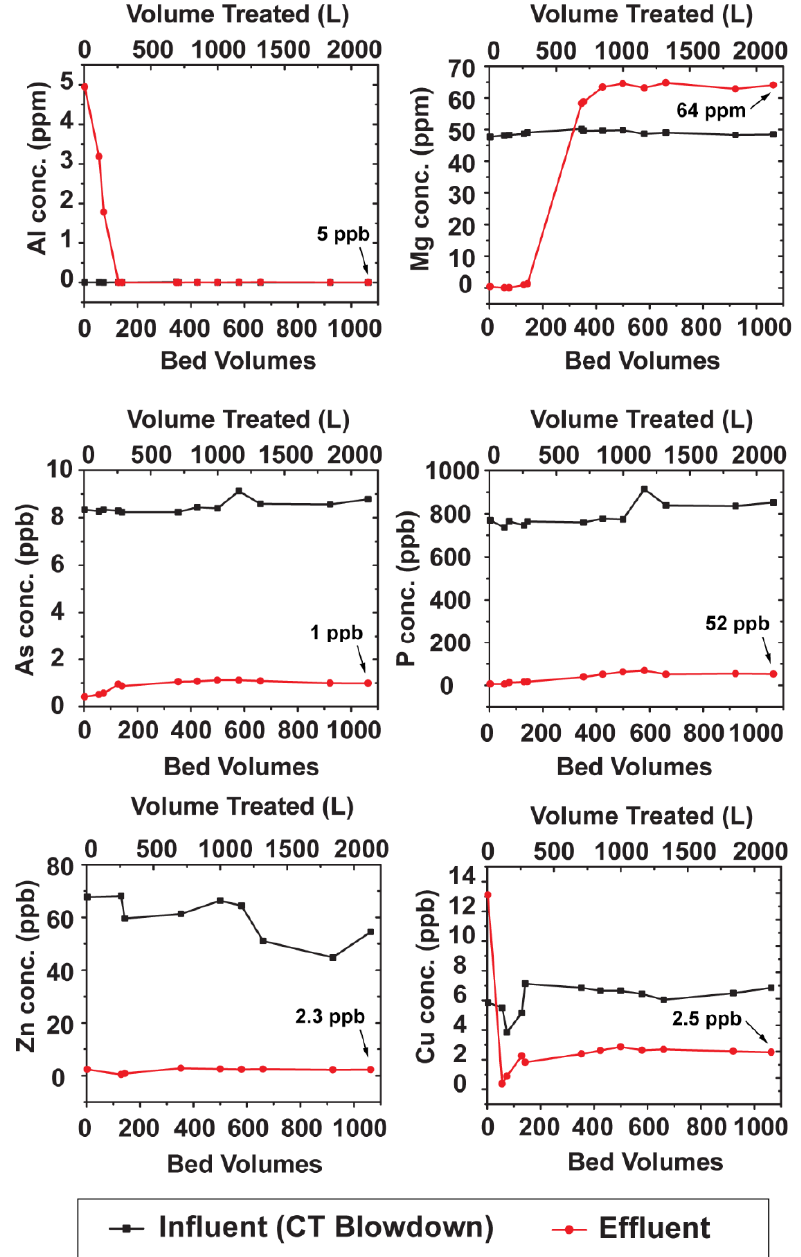
Figure 5. Concentration of select ions in CT blowdown water influent and effluent from testbed.